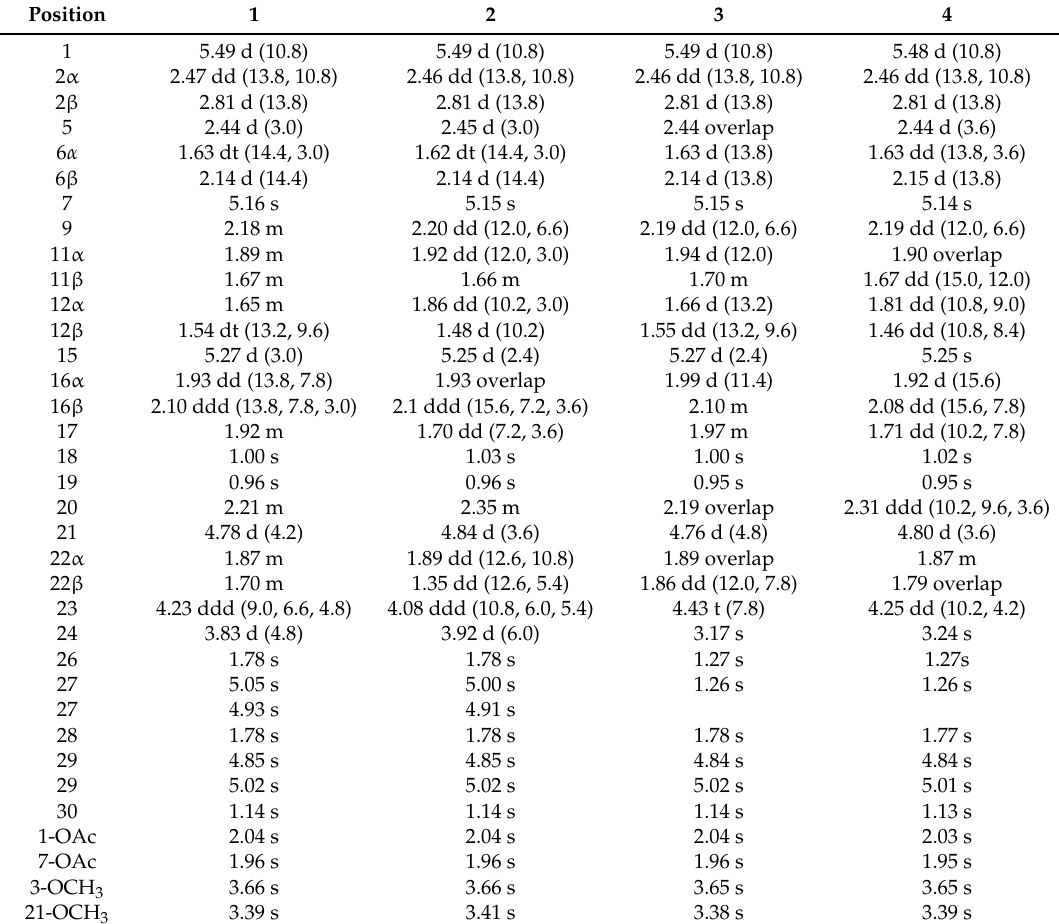
Table 1. 1 H-NMR spectroscopic data (400 MHz) of compounds 1 – 4 a